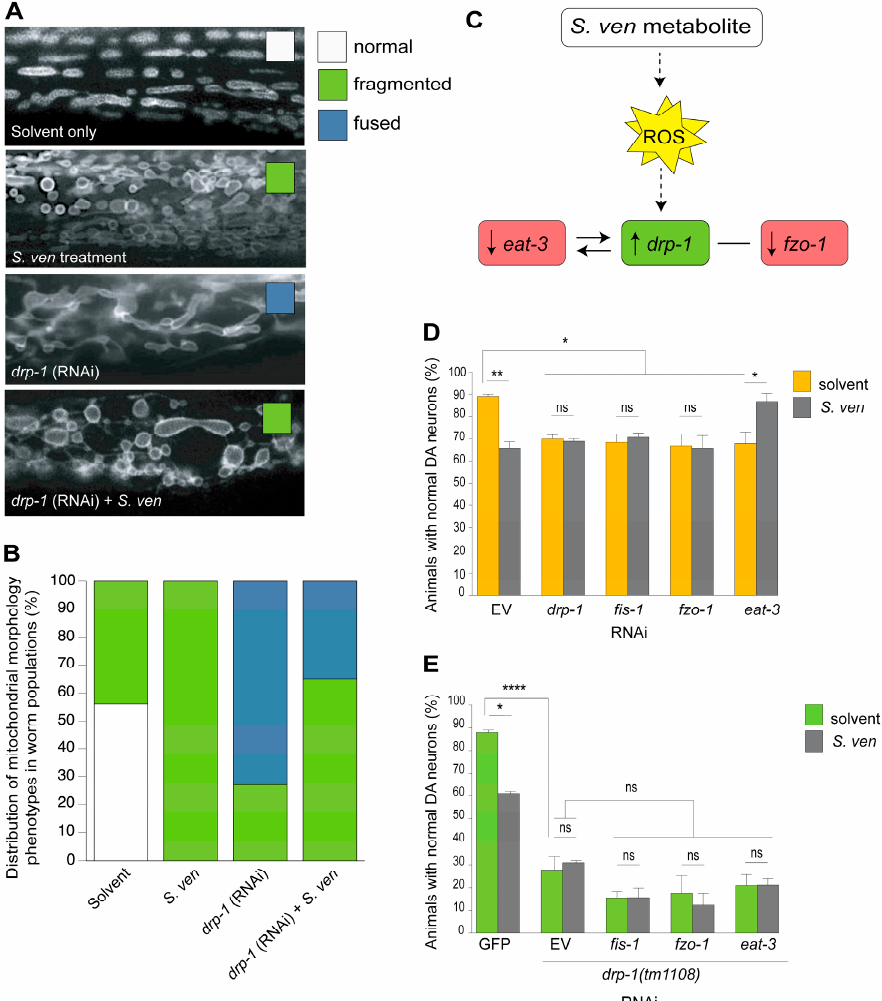
Figure 4. S. ven metabolite increases mitochondrial fragmentation. The impact of the S. ven metabolite on the mitochondrial outer membrane in C. elegans body wall muscle cells in animals expressing an outer mitochondrial protein targeted RFP (P myo 3 ::TOM20::mRFP). ( A ) Compared with solvent treatment, S. ven metabolite-treated animals exhibit significantly more mitochondrial fragmentation following exposure (green box). RNAi knockdown of drp-1 , an outer mitochondrial membrane fission gene, reveals significantly increased fusion in these animals (blue box). Notably, in drp-1 (RNAi) worms treated with S. ven , many animals return to a fragmented mitochondrial phenotype. Mitochondrial morphology is defined as normal (tubular—white box), fused (elongated—blue), or fragmented (circular and irregular—green); ( B ) Quantitation of mitochondrial morphology phenotypes in C. elegans populations. The distribution of fragmented mitochondria is different between all of the samples. In S. ven and drp-1 RNAi + S. ven treated populations, increased fragmentation is indicative of damaged mitochondria that cannot be turned over by mitophagy [83]. The color scheme (white, blue, green) is the same as shown in ( A ); ( C ) Schematic representation of qPCR data showing that S. ven metabolite exposure in C. elegans leads to increased drp-1 gene expression, as well as lowered fzo-1 and eat-3 gene expression [83]. DRP-1 is an outer mitochondrial membrane fission protein, while FZO-1 and EAT-3 are fusion proteins that are located at the outer and inner mitochondrial membranes, respectively; ( D ) eat-3 (RNAi) knockdown suppresses dopaminergic neurotoxicity caused by the metabolite. Notice that the knockdown of all of the other mitochondrial fission and fusion genes still causes toxicity in the presence of metabolite, except for eat-3 (RNAi), which now exhibits neuroprotection; ( E ) The RNAi sensitive strain used in part D (above) was crossed to drp-1 loss-of-function mutant (allele tm1108 ) animals. In this background, all of the fission and fusion genes that were examined display enhanced sensitivity to neurodegeneration, notably, eat-3 (RNAi ); drp-1(tm1108) no longer shows resistance in the presence of the metabolite.